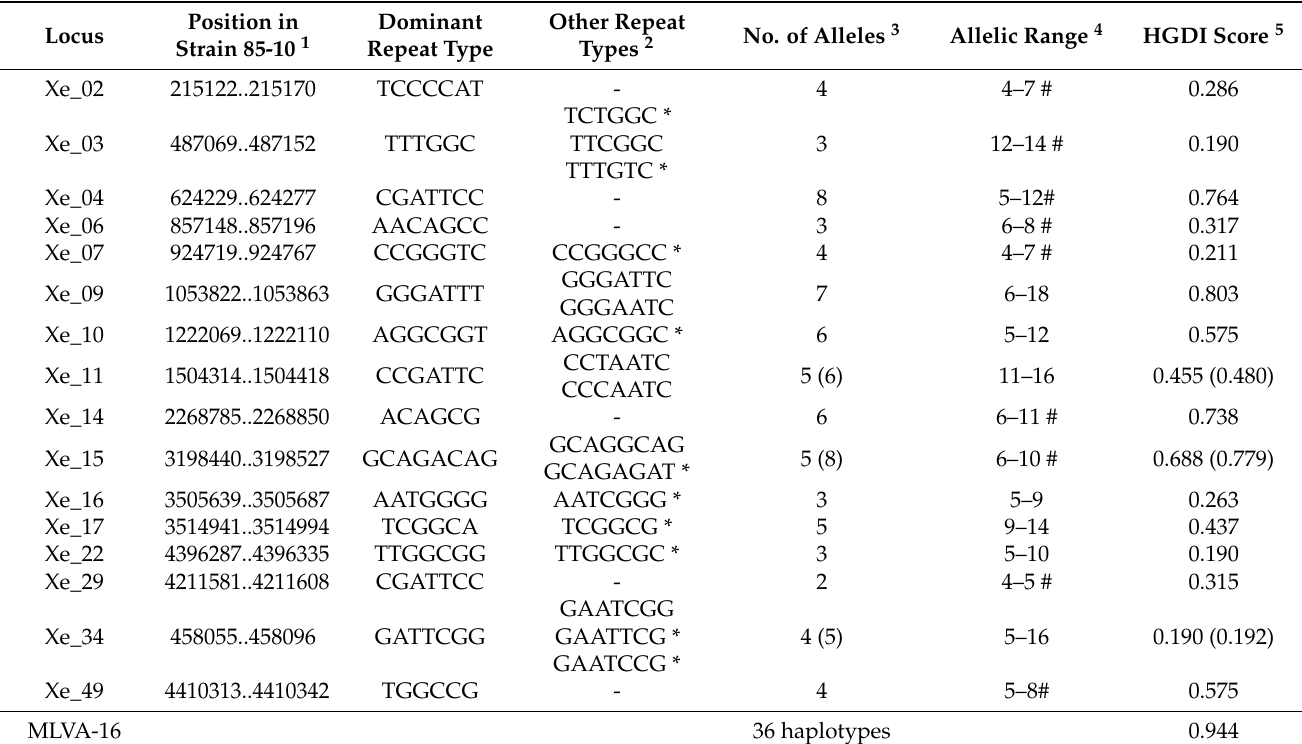
Table 1. Characteristics of variable number of tandem repeats (VNTR) and Hunter–Gaston Discriminatory Index (HGDI) scores for the 16 loci of the multilocus variable number of tandem repeat analyses (MLVA)